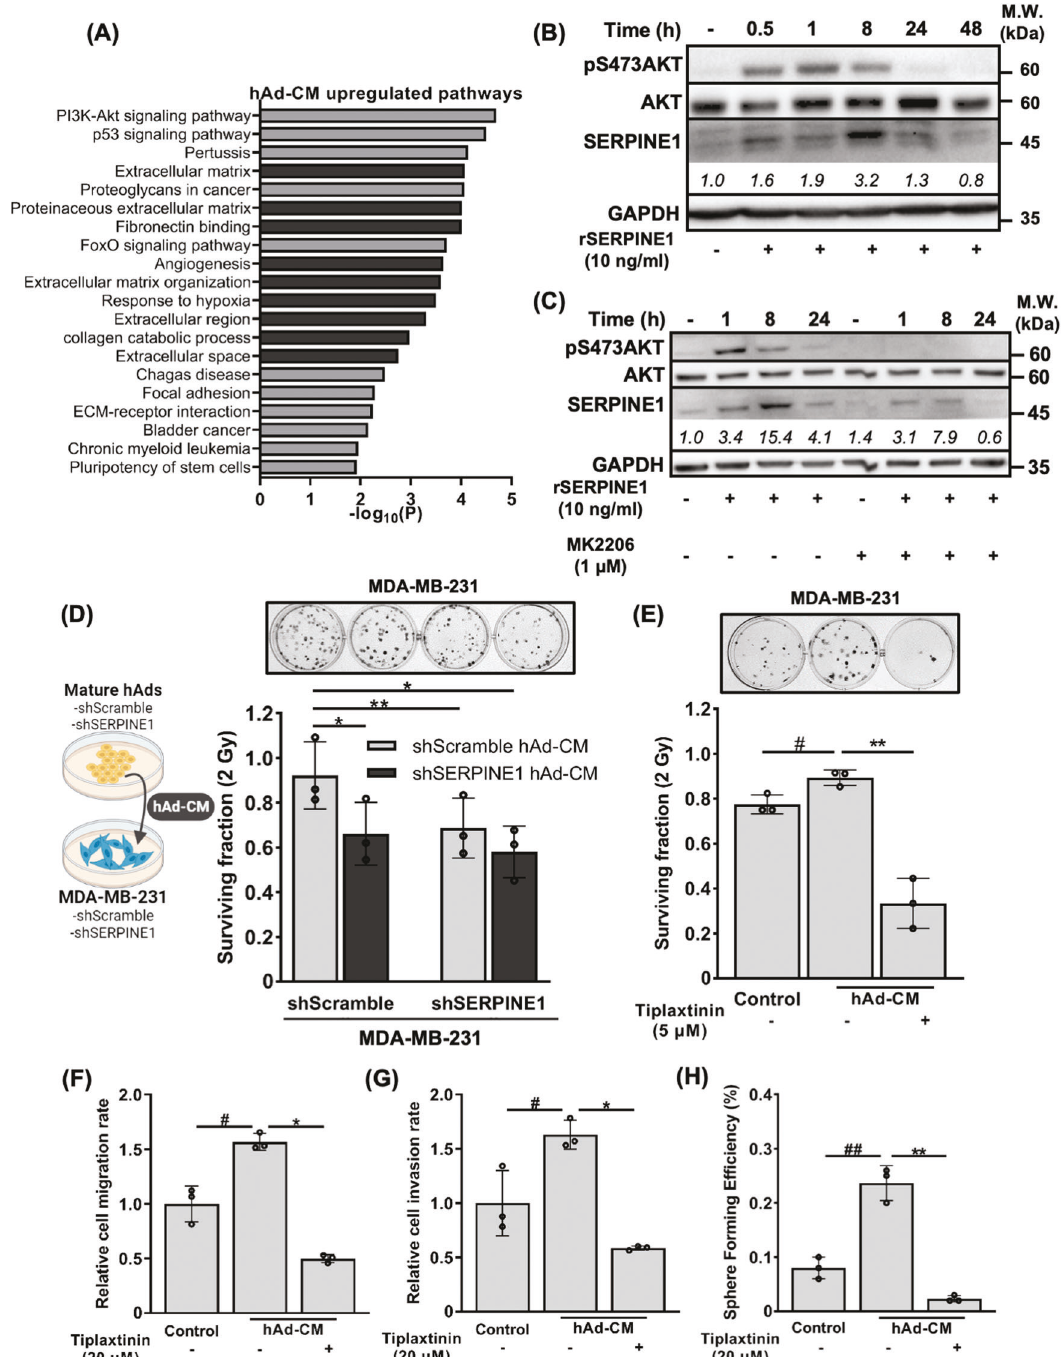
Fig. 5 SERPINE1 activated AKT signaling and contributed to radioresistance and aggressive phenotypes of MDA-MB-231 cells cultured with hAd-CM. A Pathway analysis using DAVID bioinformatics database. Top 20 upregulated biological pathways categorized by KEGG (light gray) or GO (dark gray) in MDA-MB-231 cells cultured with hAd-CM. B , C AKT phosphorylation and SERPINE1 induction in MDA-MB-231 cells treated with 10 ng/mL rSERPINE1 and 1 μ M MK2206 were detected by western blotting. MK2206 was pre-treated 1 h prior to rSERPINE1 supplement. Clonogenicity of SERPINE1 -knockdown MDA-MB-231 cells cultured with indicated hAd-CM ( D ) or parental MDA-MB- 231 cells cultured with hAd-CM containing DMSO or 5 μ M Tiplaxtinin ( E ) for 3 days followed by IR. Surviving fraction upon 2 Gy IR exposure was quanti fi ed. Representative images were shown above. The migratory capacity ( F ), invasiveness ( G ), and stemness status ( H ) of MDA-MB- 231 cells cultured with hAd-CM containing DMSO or 20 μ M Tiplaxtinin for 3 days were assessed by transwell assay and tumorsphere formation assay.